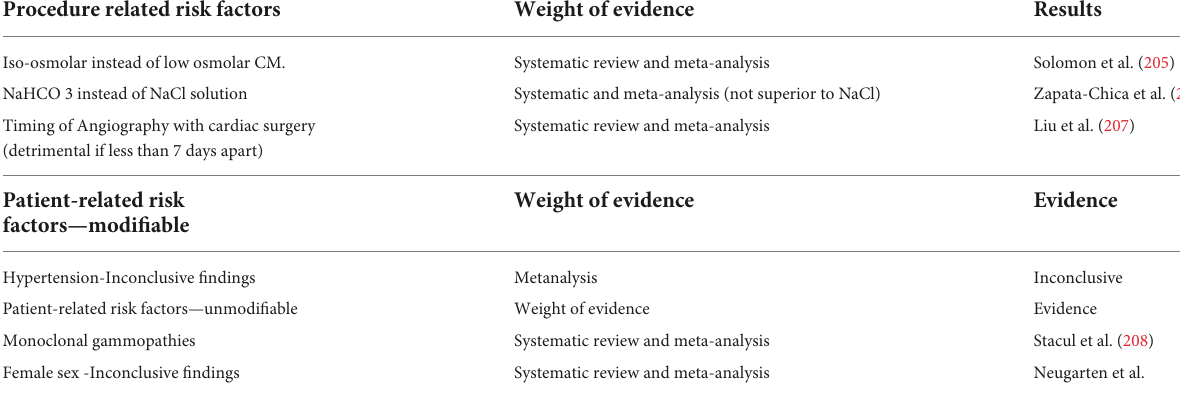
TABLE 4 Unproven risk factors of